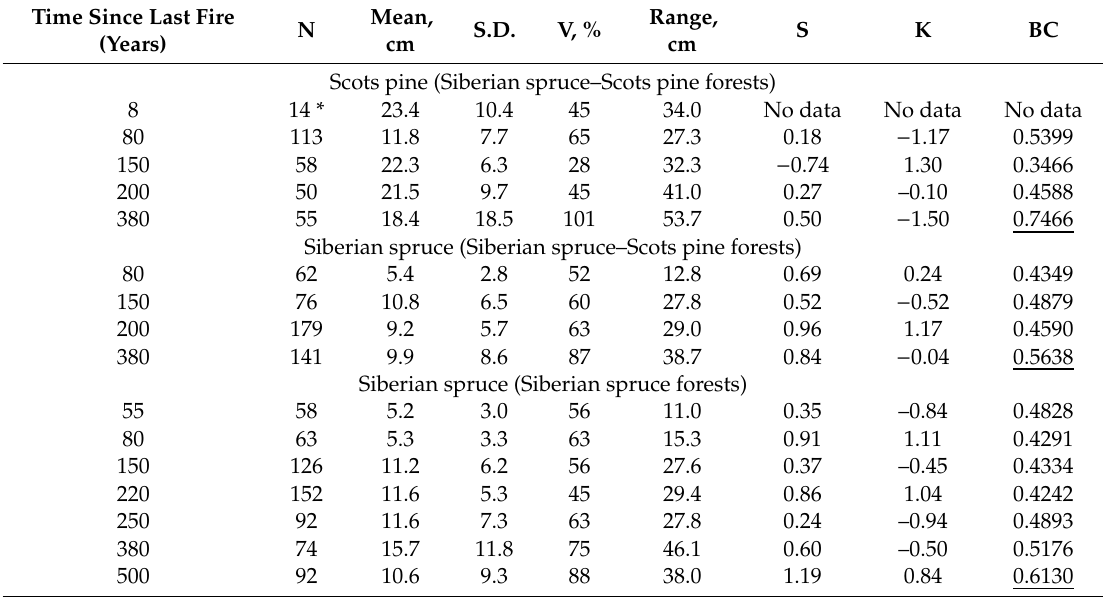
Table 2. Statistical parameters of diameter class distributions of Pinus sylvestris and Picea obovata trees in Siberian spruce–Scots pine and Siberian spruce forests.